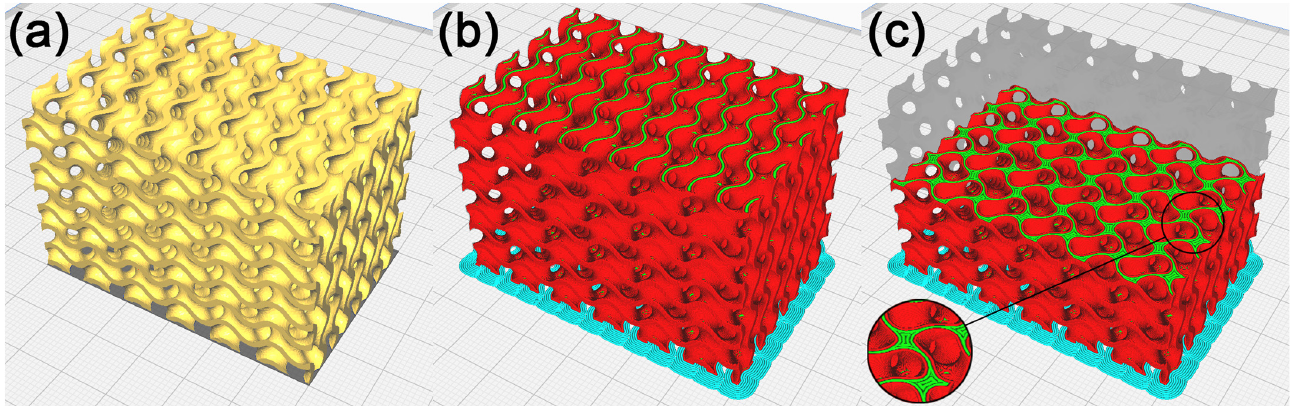
Figure 15. Recalculated cellular structure model. ( a ) Model in Cura, ( b ) illustration of the toolpath process of manufacture with FDM technology, and ( c ) illustration of the toolpath in the model’s inner layer.